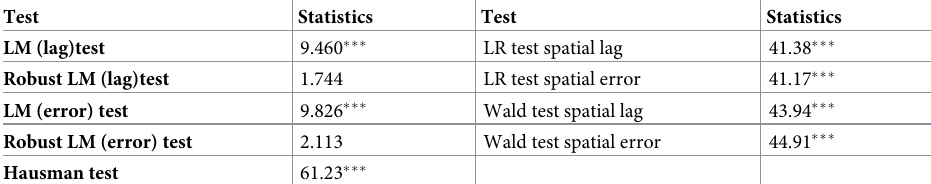
Table 8. Spatial models specification